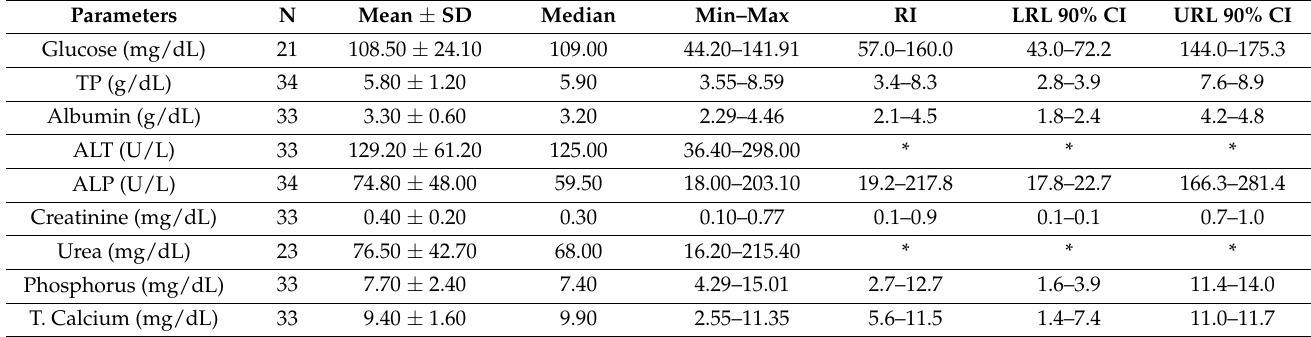
Table 2. Reference intervals of biochemical parameters in 37 healthy animals of the species Erinaceus europaeus